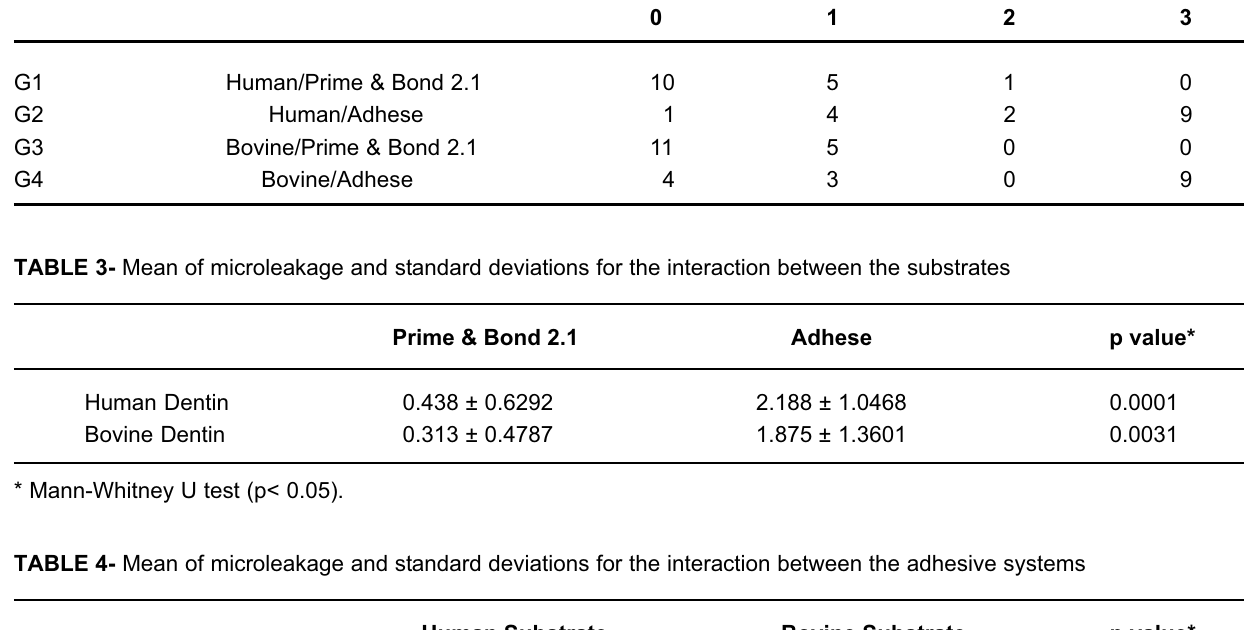
TABLE 2- Frequency of marginal leakage in the cervical wall in different experimental conditions